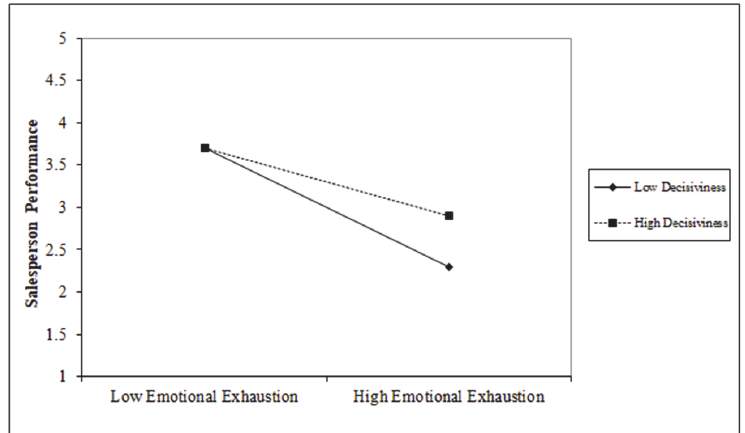
Fig. 3. Simple slope